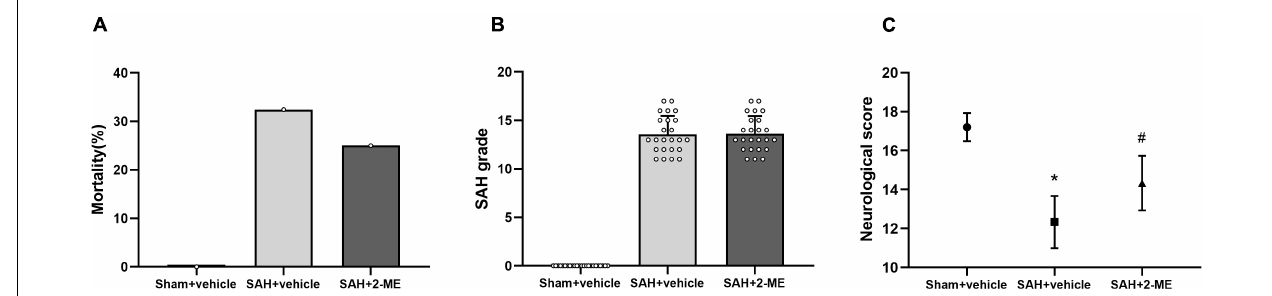
FIGURE 1 | Effect of 2-ME on mortality, SAH grading, and neurological functions. (A) Mortality in Sham + vehicle ( n = 24), SAH + vehicle ( n = 35), and SAH + 2-ME ( n = 32) groups. (B) SAH grade in different groups ( n = 24 per group). Data are shown as mean ± SD . (C) Neurological score in different groups ( n = 24 per group). Values are median (interquartile range) *P < 0.05 vs. the Sham + vehicle group; # P < 0.05 vs. the SAH + vehicle